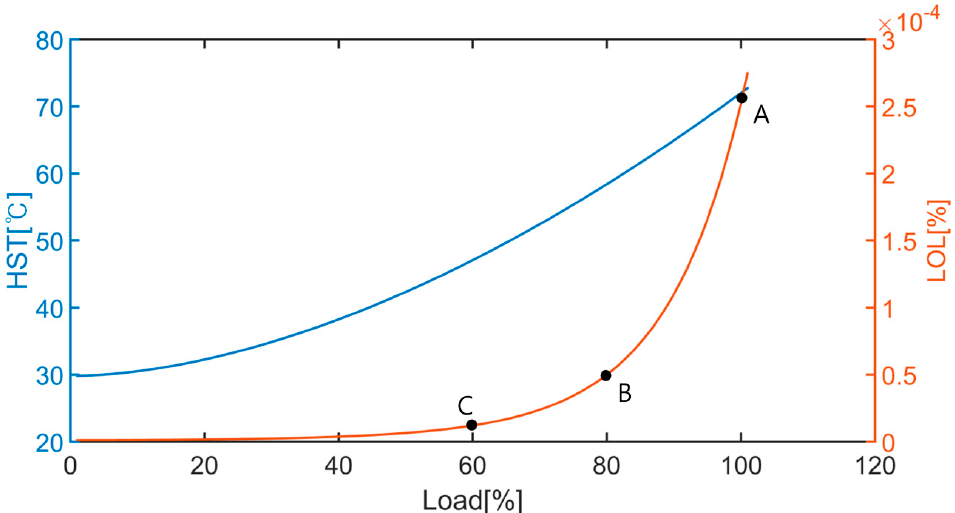
Figure 4. Hottest Spot Temperature (HST) and Loss of Life (LOL) of an example Distribution Transformer (DT) for different loading